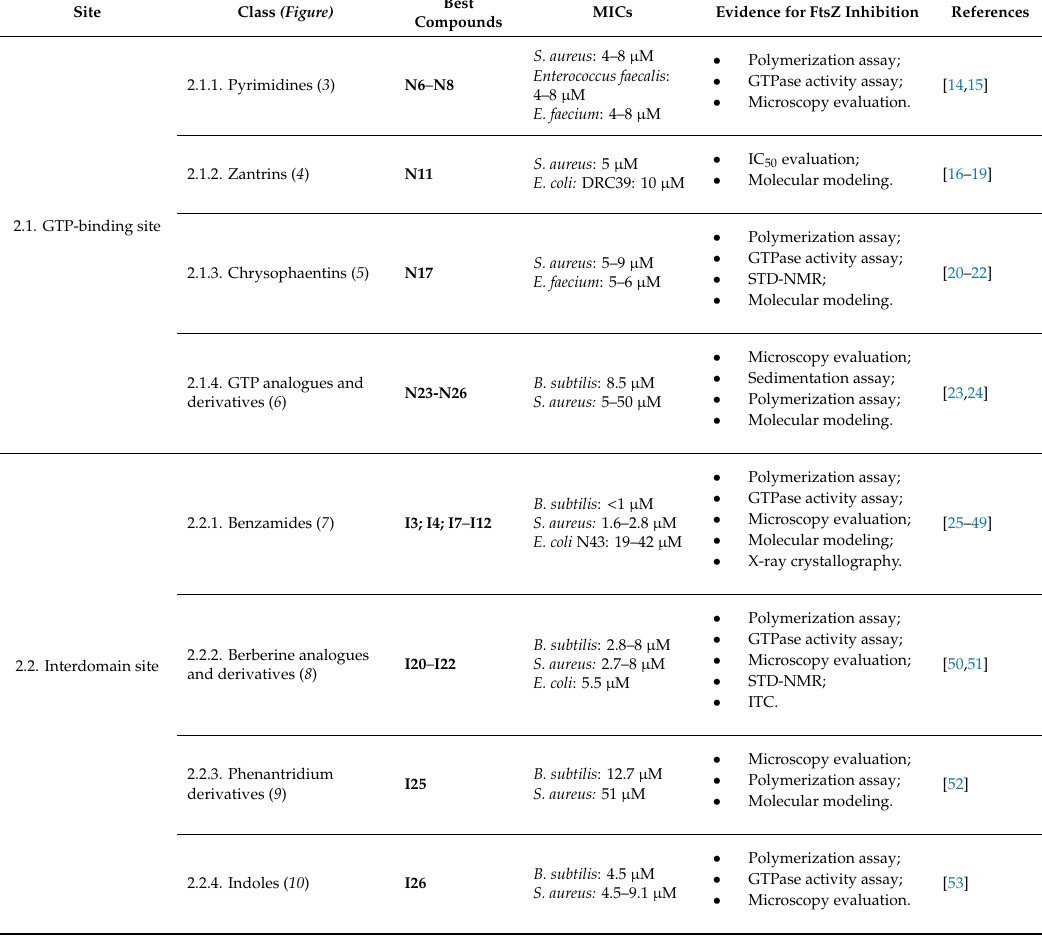
Table 1. General overview of the best FtsZ inhibitors. MIC—minimum inhibitory concentration; IC 50 —half maximal inhibitory concentration; STD—saturation transfer di ff erence; ITC—isothermal titration